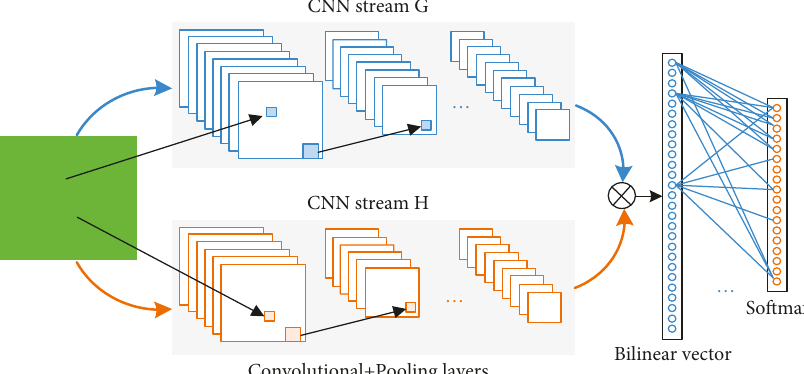
Figure 1: B–CNN model structure